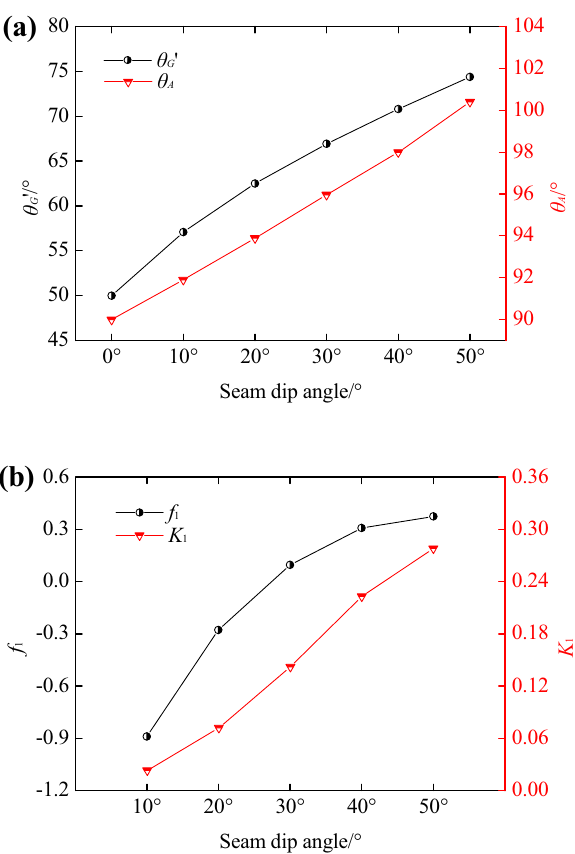
and h A ; b K 1 and f 1 G